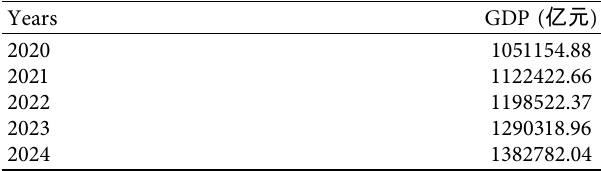
Table 7: Forecast of China’s GDP in the next five years (unit: 100 million yuan).